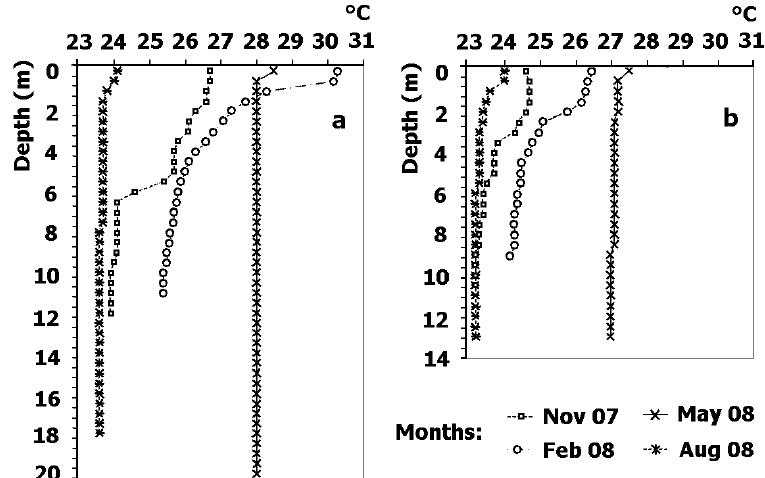
Fig. 2 – Temperature profile in Arcoverde (a) and Pedra (b) reservoirs (Pernambuco State, Brazil) between November 2007 and August 2008; dry months: Nov 07 and Feb 08; rainy months: May 08 and Aug 08.